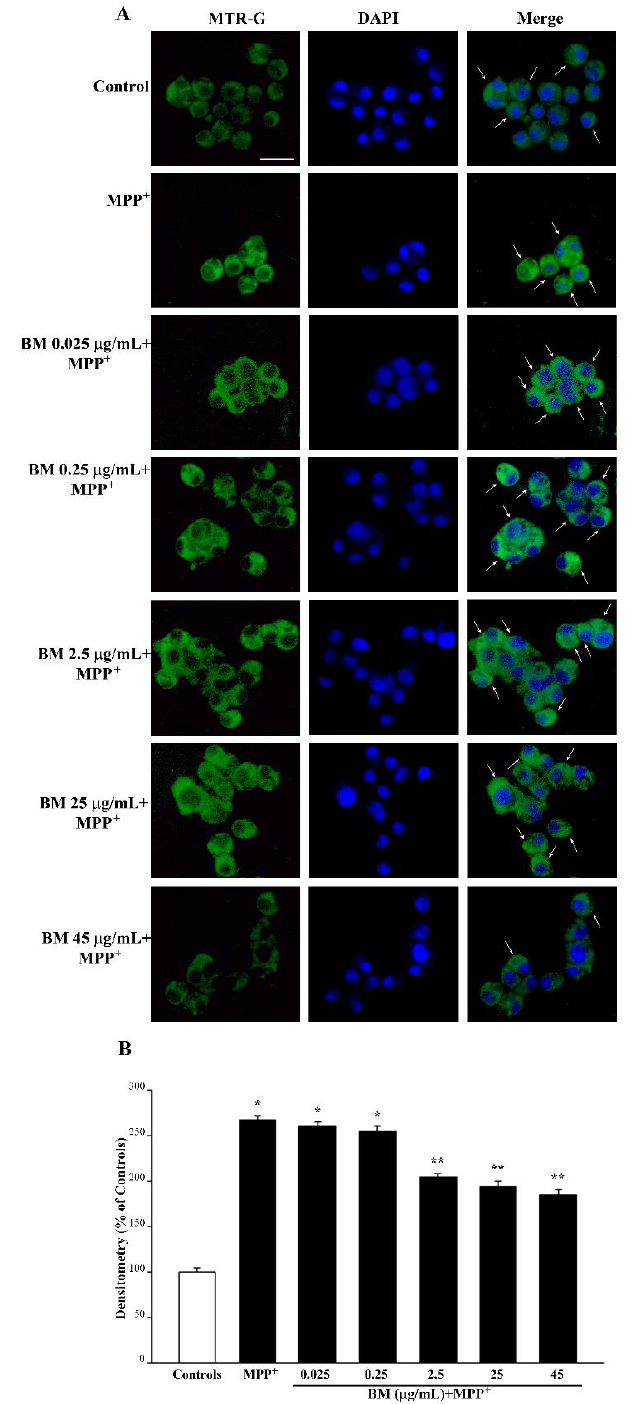
Figure 13. MitoTracker Green (MTR-G) fluorescent cells after combined administration of BM and MPP + . ( A ) Representative pictures of MTR-G fluorescence show that MPP + increases MTR- G fluorescence compared with control. This effect is less pronounced when MPP + is given in combination with BM from the dose of 2.5 µ g/mL up to the dose of 45 µ g/mL. This replicates what is observed under BM alone. Cell nuclei are stained in blue with DAPI. The graph in ( B ) reports the measures of the MTR-G fluorescence intensity. Values are given as mean percentage ± S.E.M. of optical density (assuming controls as 100%) from three independent experiments. * p < 0.05 compared with controls; ** p < 0.05 compared with MPP + . Scale bar = 17 µ